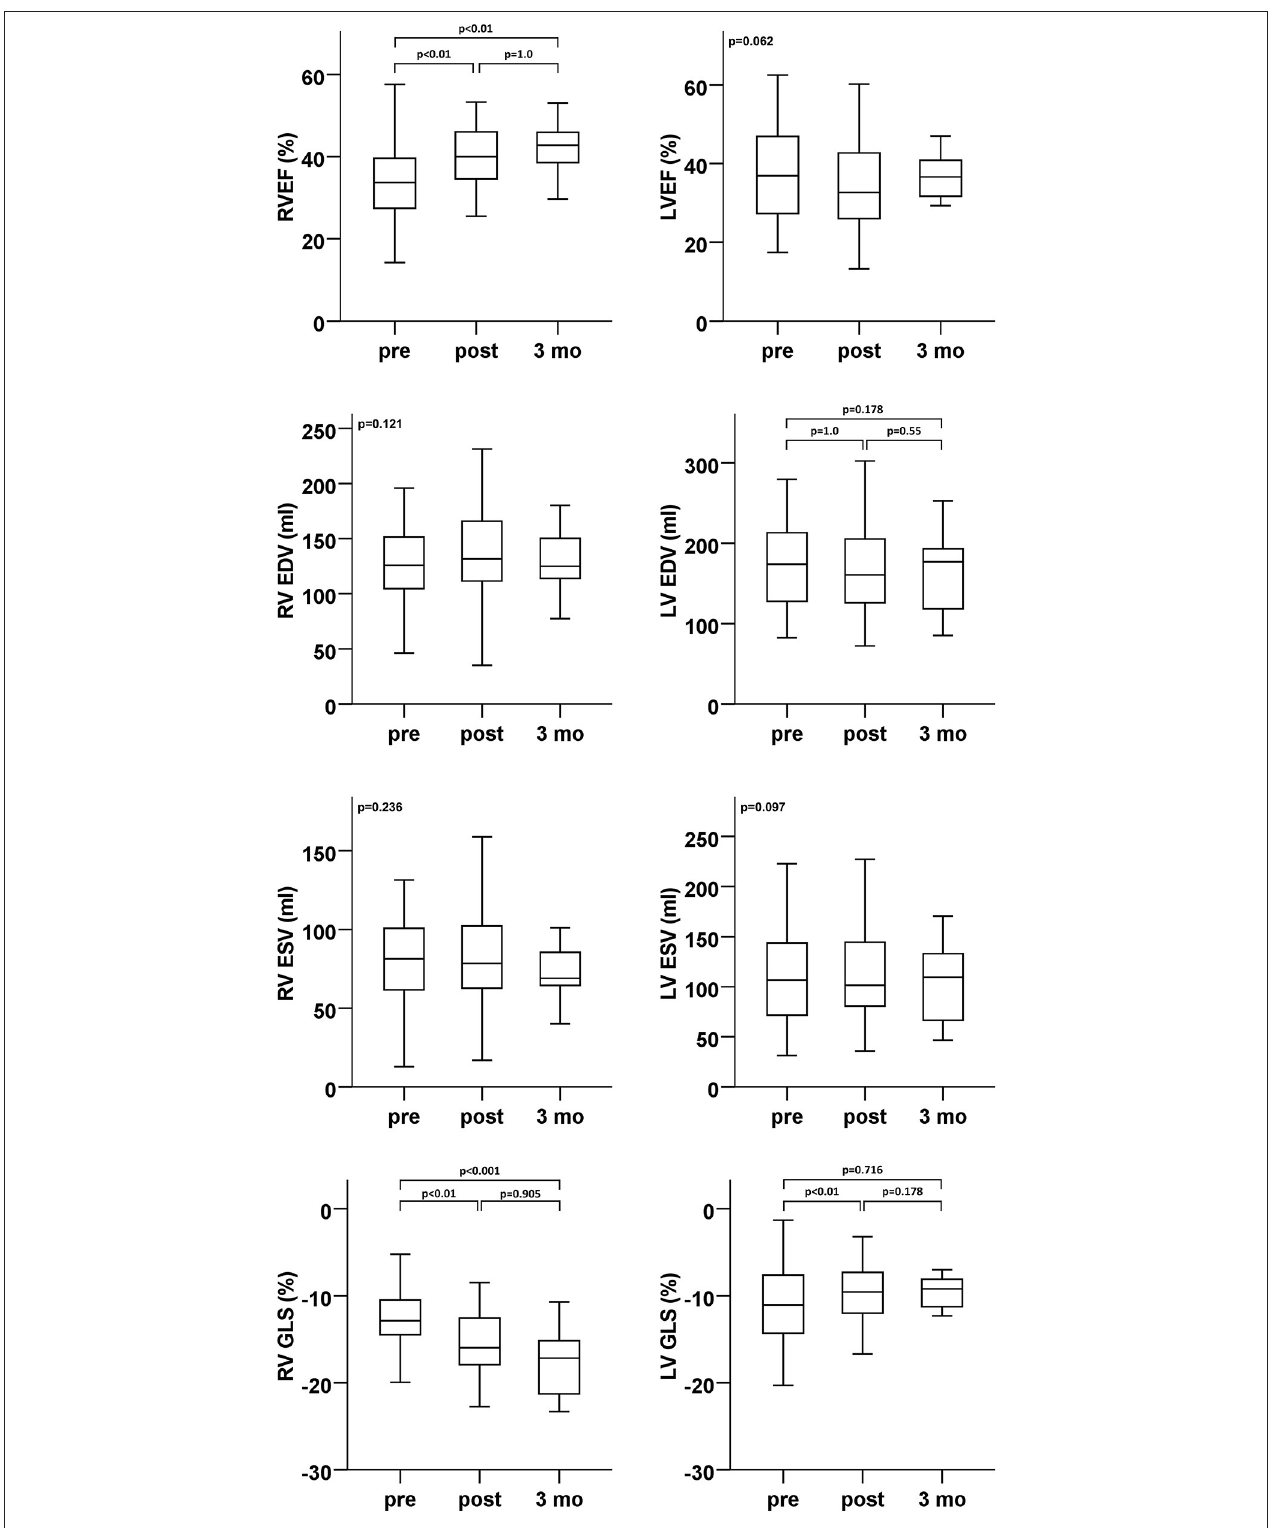
FIGURE 2 | Ventricular function (ejection fraction and global longitudinal strain) and volumes (enddiastolic and endsystolic)–echocardiographic analyses of LV (right column) and RV (left column) parameters at baseline (pre), dismission (post), and 3 months after percutaneous mitral valve repair (PMVR). EDV, end diastolic volume; ESV, end systolic volume; GLS, global longitudinal strain; LV, left ventricle; LVEF, left ventricular ejection fraction; RV, right ventricle; RVEF, right ventricular ejection fraction.